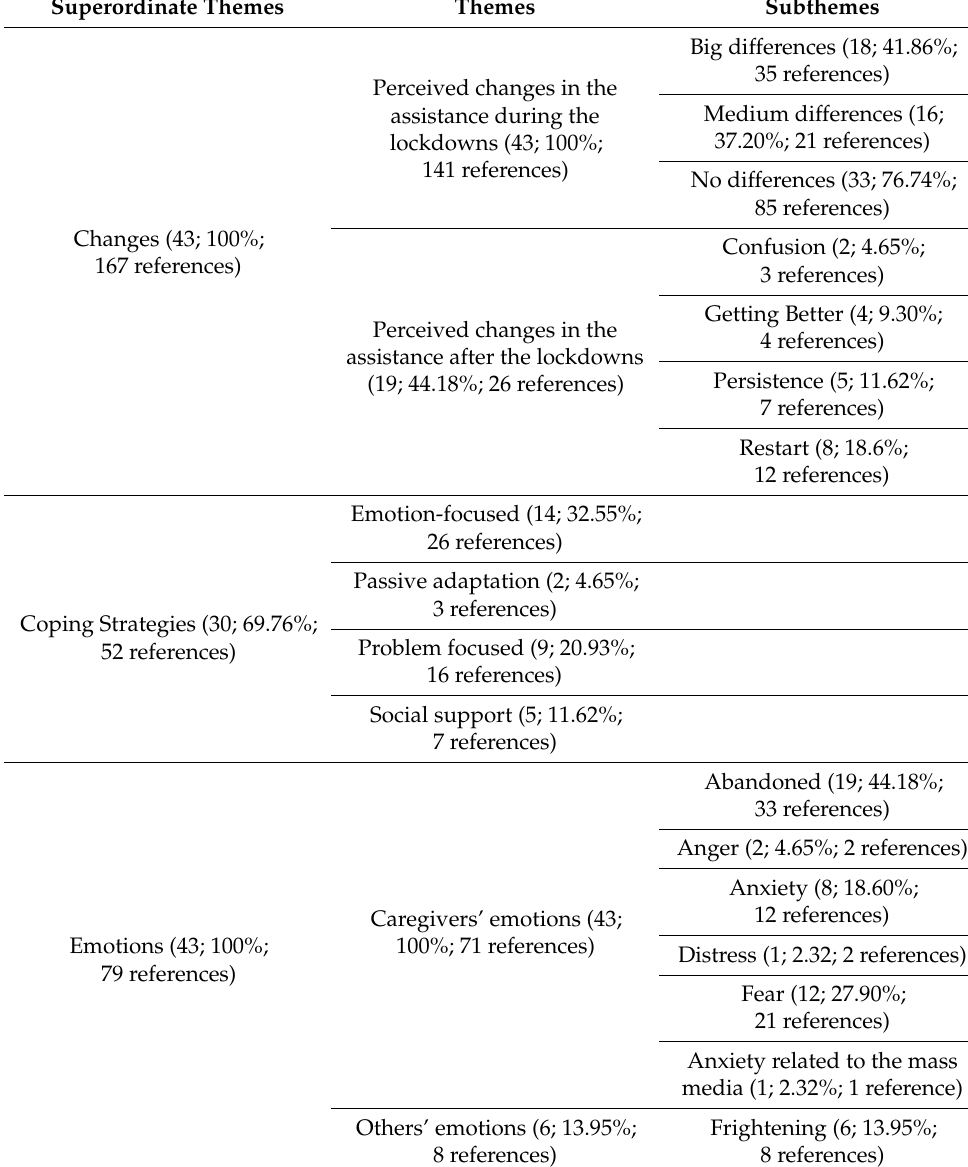
Table 4. Organisation of superordinate themes, themes and subthemes emerging from the analyses. Superordinate